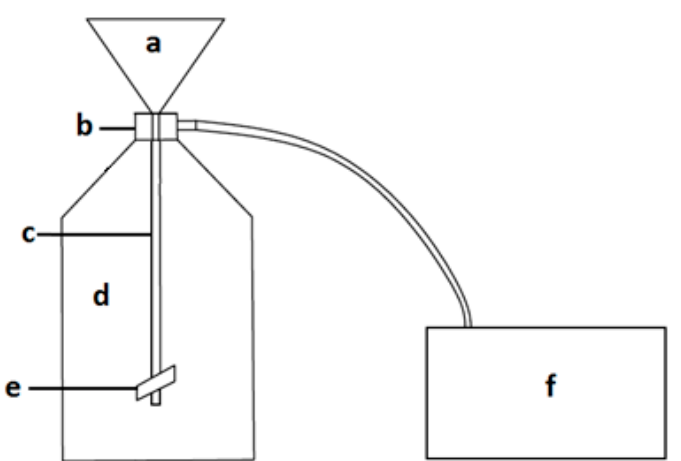
Figure 1. Low-vacuum filtration (LVF) system: ( a ) closed liquid container; ( b ) a coupler connecting the dialysis membrane with the liquid container; ( c ) dialysis membrane; ( d ) a vacuum chamber; ( e ) a clamp closing the membrane; ( f ) a pump.